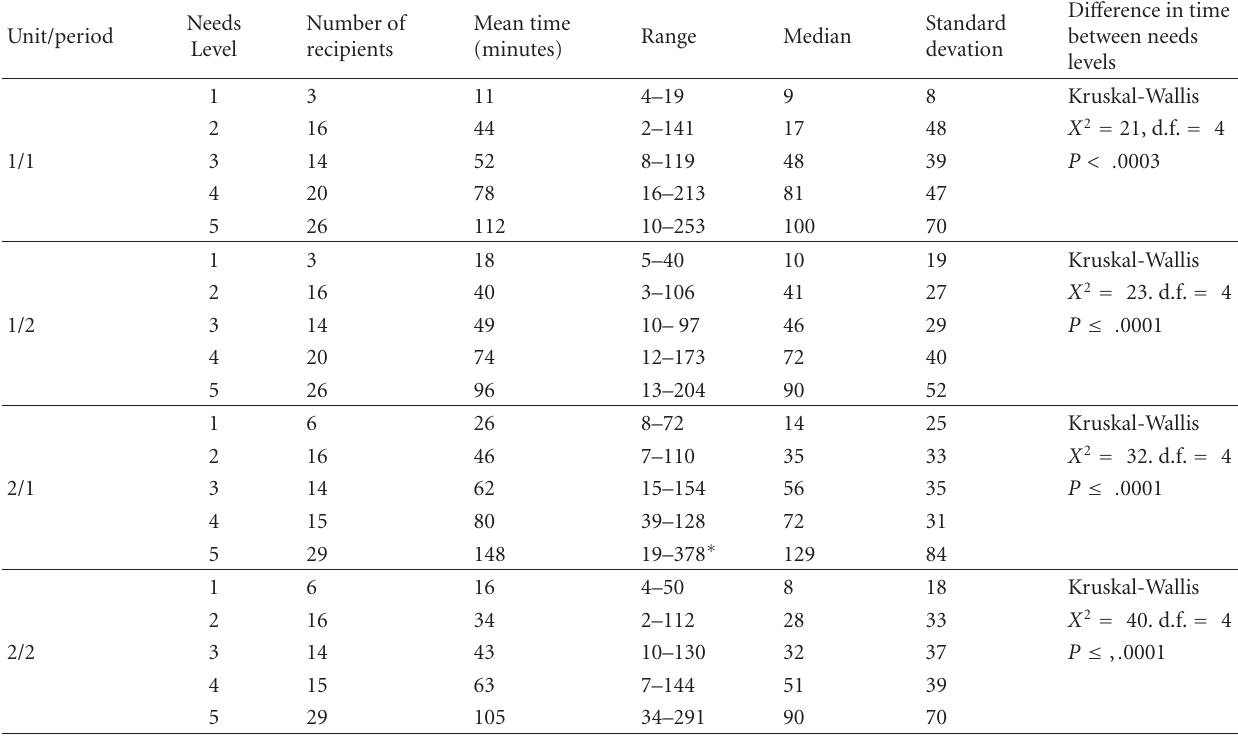
Table 4: Level of care needs and time spent fulfilling them in mean minutes per day in each unit during periods 1 and